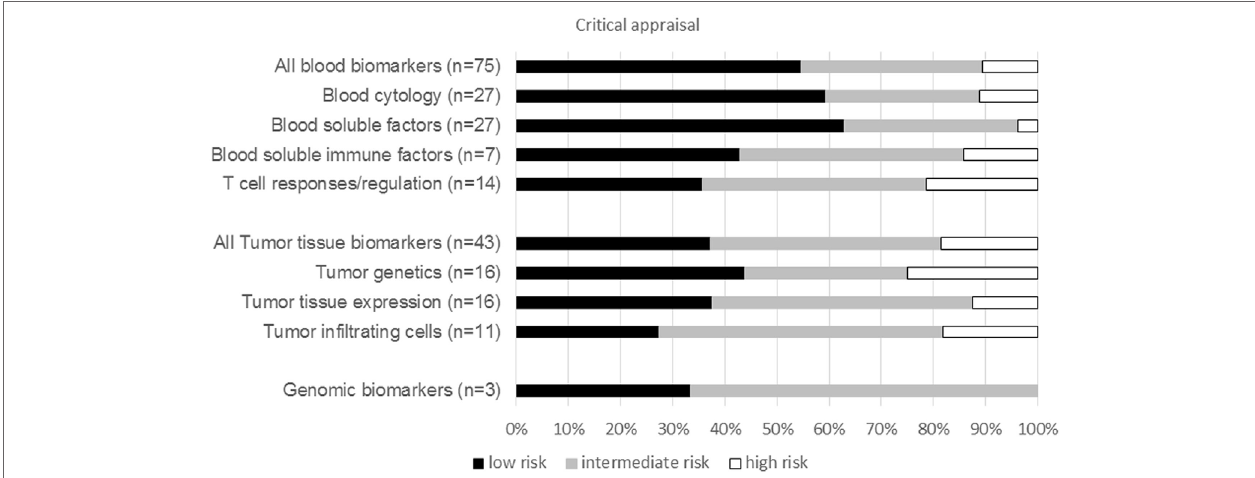
FiGURe 3 | Critical appraisal. Graph show the percentage of publications per biomarker type for both CTLA-4 and PD1 immune checkpoint inhibitor with a low, intermediate, or high risk of bias. n , total number of publications per biomarker